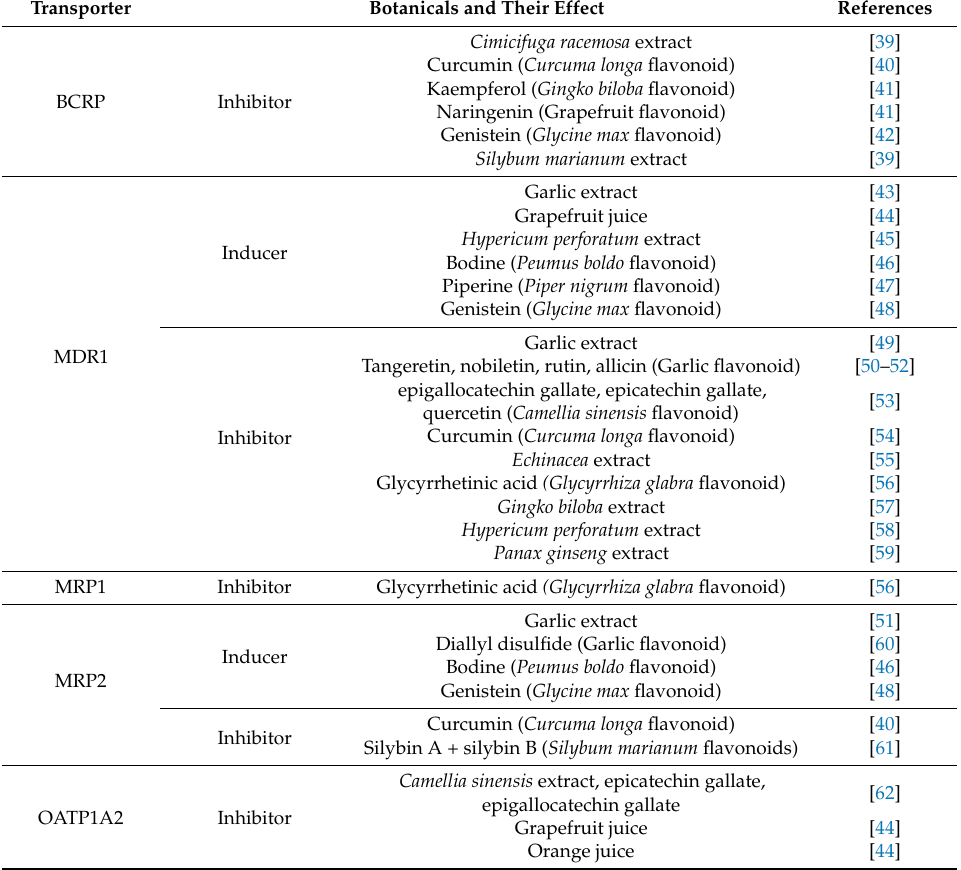
Table 1. The selective in vitro studies revealing the role of various botanical supplements in the inhibition/induction of various